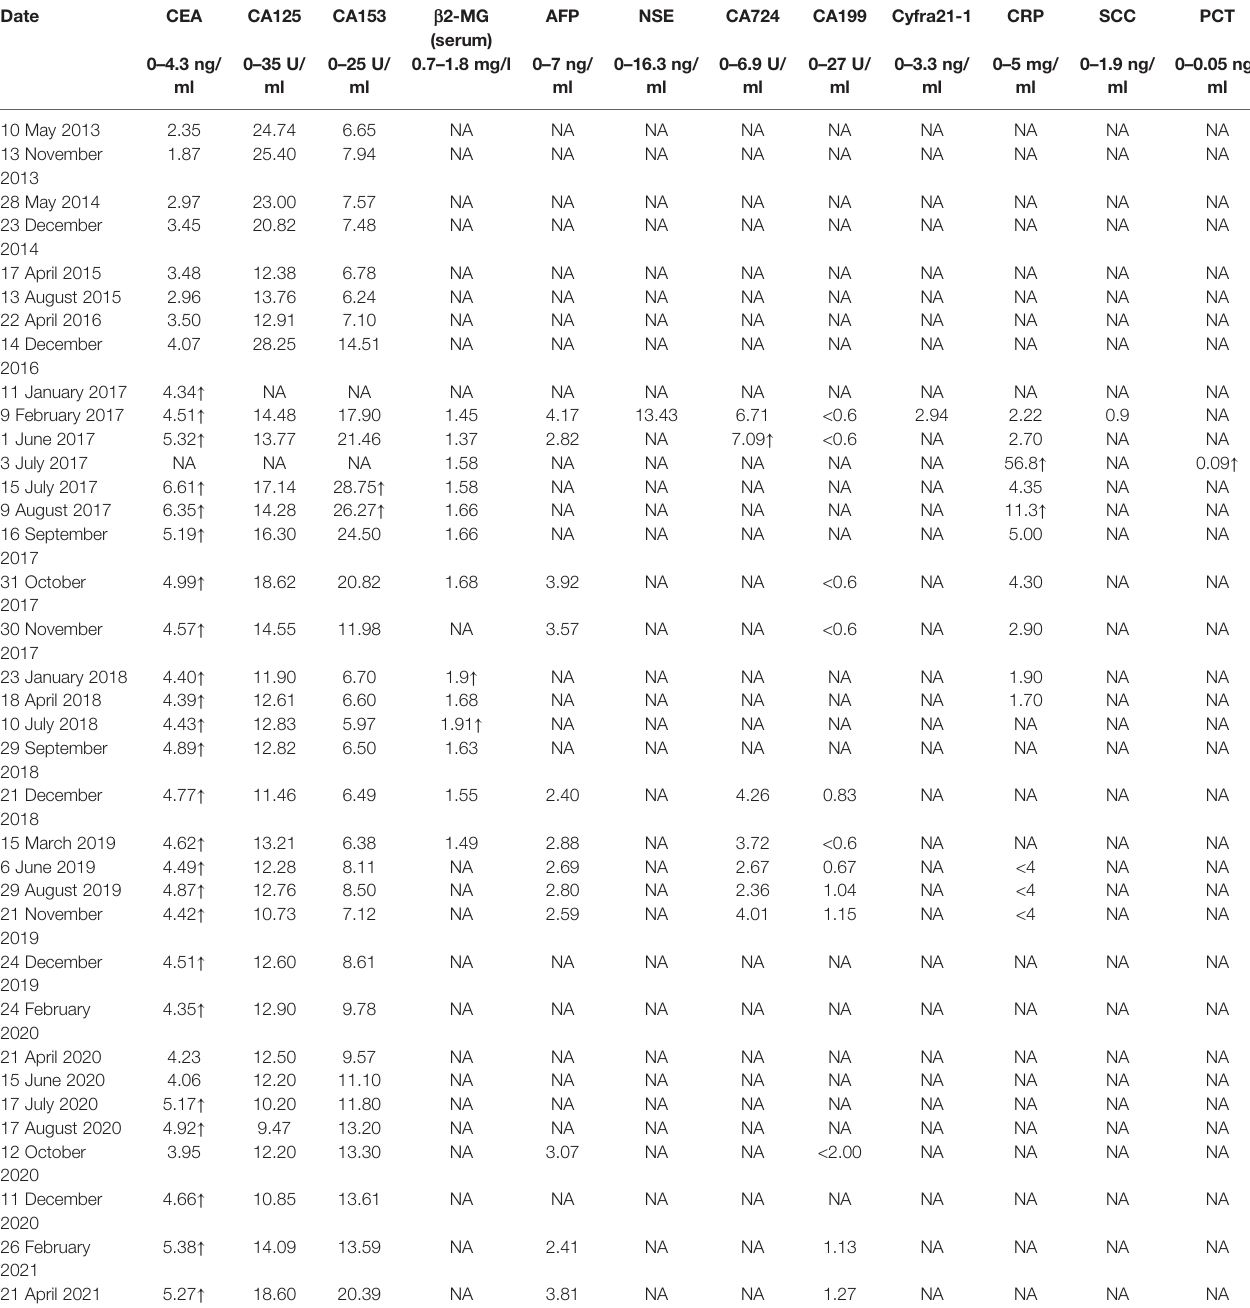
TABLE 1 | The levels of serum biomarkers during the